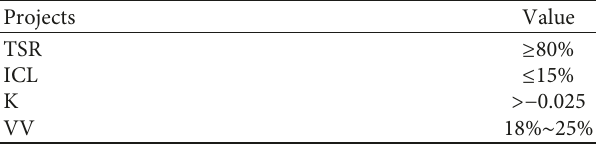
Table 2: The values of the key index. Projects